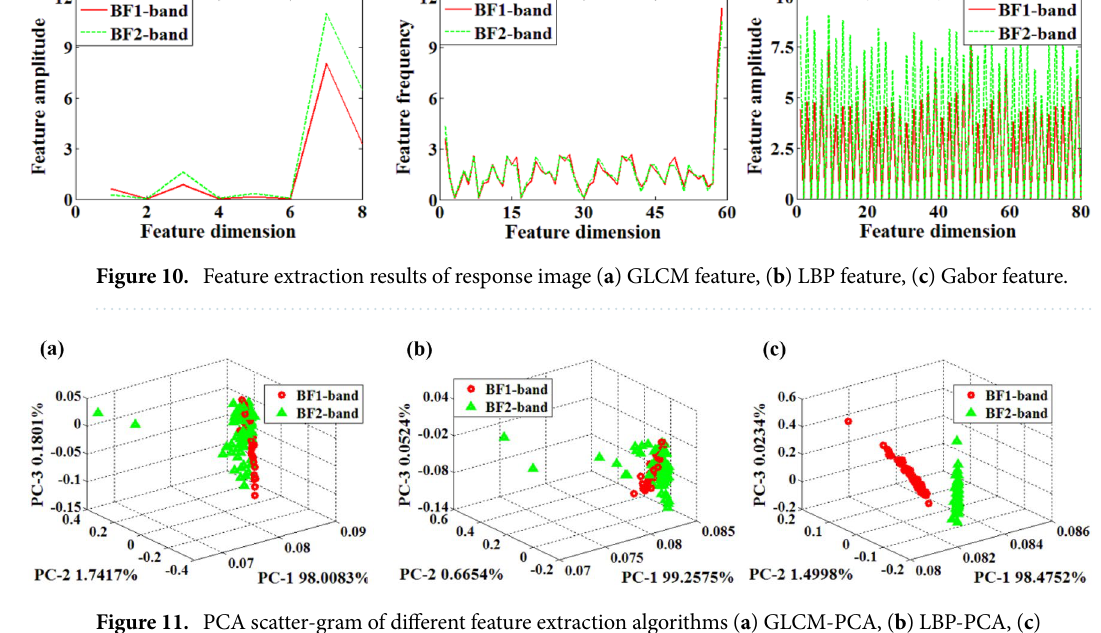
Figure 11. PCA scatter-gram of different feature extraction algorithms ( a ) GLCM-PCA, ( b ) LBP-PCA, ( c )